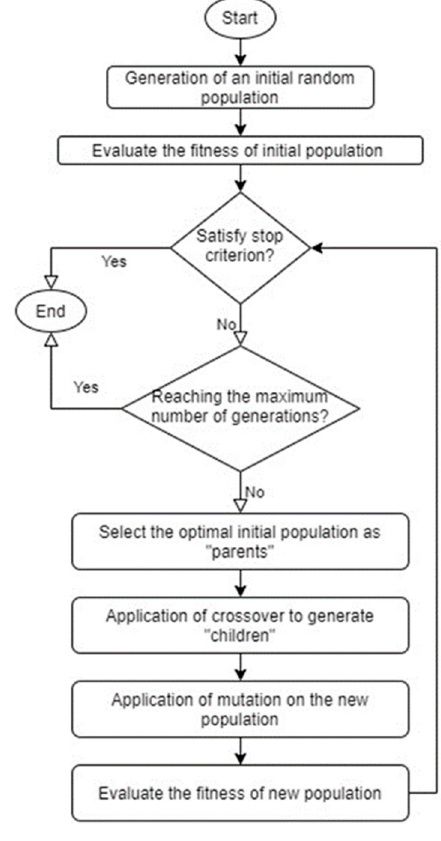
Figure 9. GA Figure 9. GA Flowchart.